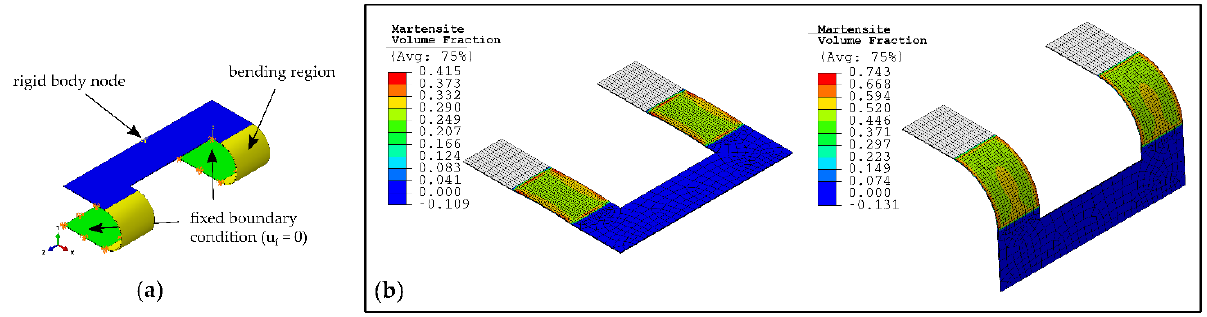
Figure 9. Finite element simulation of moment-controlled unfolding of a single microactuator at 24°C: ( a ) boundary conditions of the 3D structure; ( b ) two folding configurations and corresponding local profile of martensite phase fraction indicated in color.